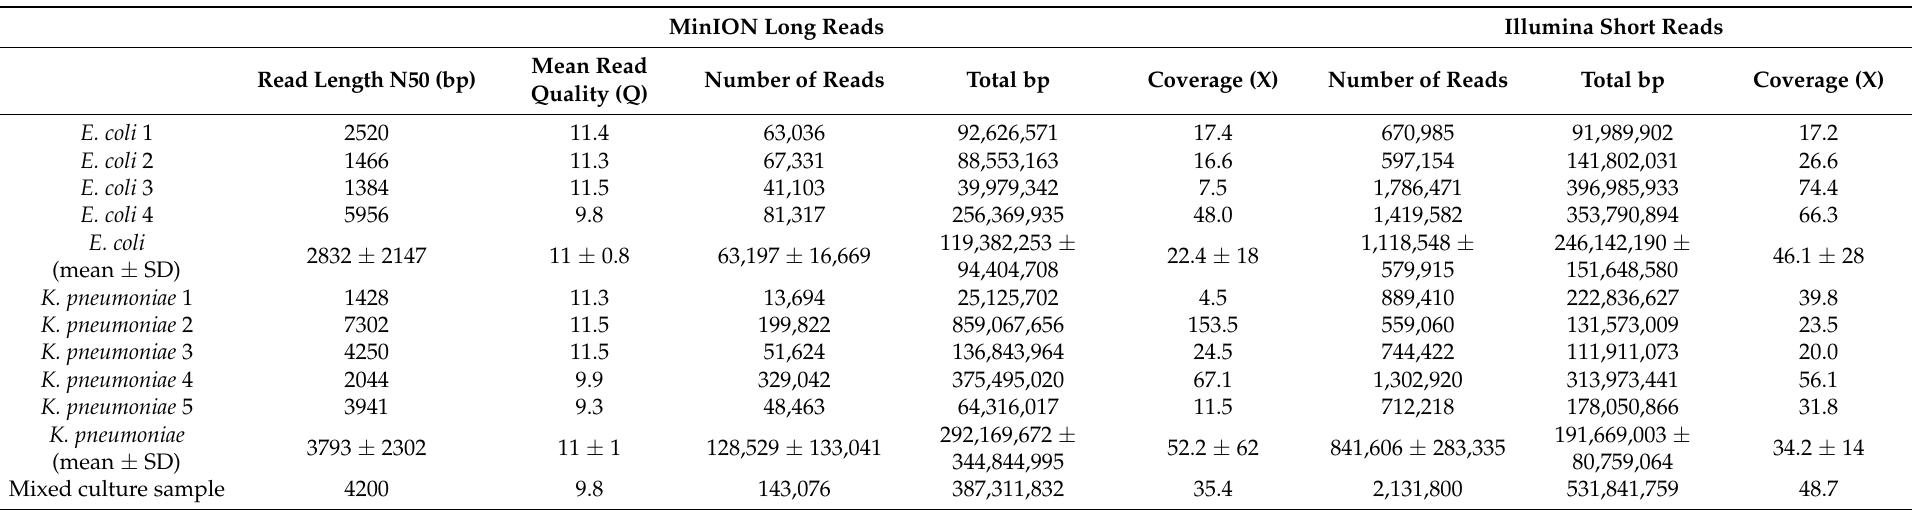
Table 1. An overview of basic sequence information statistics and quality of reads after trimming and filtering. The mixed culture was obtained from the co-culturing of E. coli 4 and K. pneumoniae 5 isolates. Coverage of E. coli isolates was calculated by dividing the number of bp in each read over the number of bp in reference genome ( E. coli NCTC 13441). Coverage of K. pneumoniae isolates was calculated by dividing the number of bp reads over the number of bp reads in the K. pneumoniae reference genome (median genome size of all K. pneumoniae isolates in NCBI database). Coverage of mixed culture sample was calculated by dividing the number of bp in mix culture sample over the sum of pb of E. coli NCTC 13441 and median genome size of all K. pneumoniae isolates in NCBI